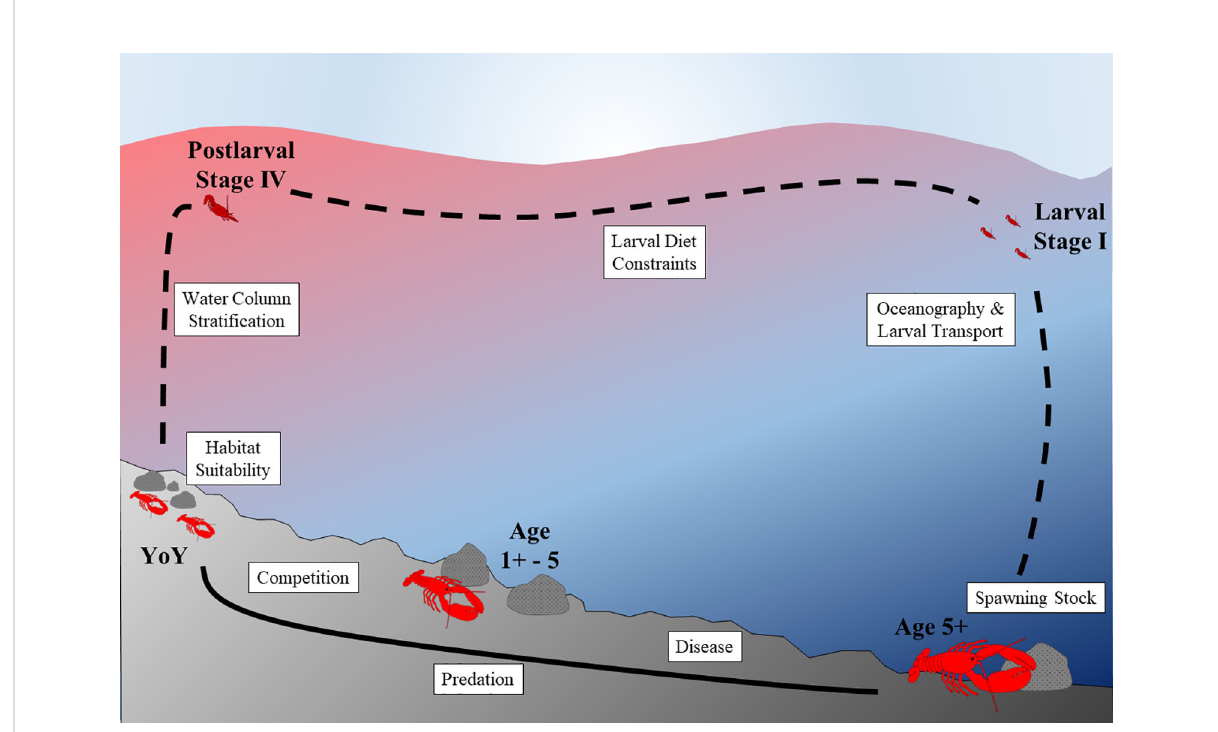
FIGURE 3 Conceptual model of American lobster life history and the settlement processes in fl uencing recruitment to the fi shery. Mechanisms in fl uencing pre-settlement processes are indicated along the dashed line, and those in fl uencing post-settlement processes are indicated using solid